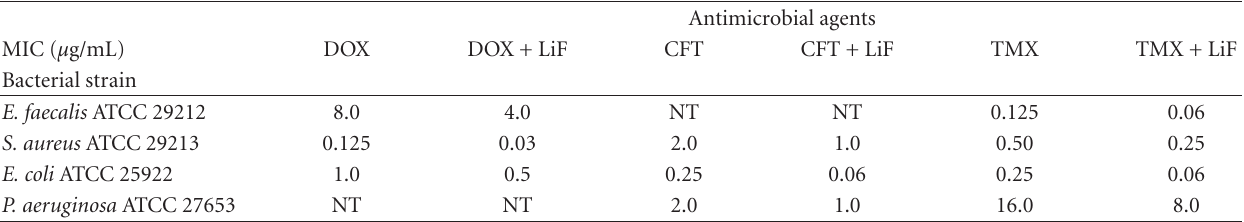
Table 1: MICs ( µ g/mL) of doxycycline, ceftazidime, and sulfamethoxazole-trimethoprim alone or in combination with LiF on Enterococcus faecalis , Staphylococcus aureus , Escherichia coli , and Pseudomonas aeruginosa . Antimicrobial agents